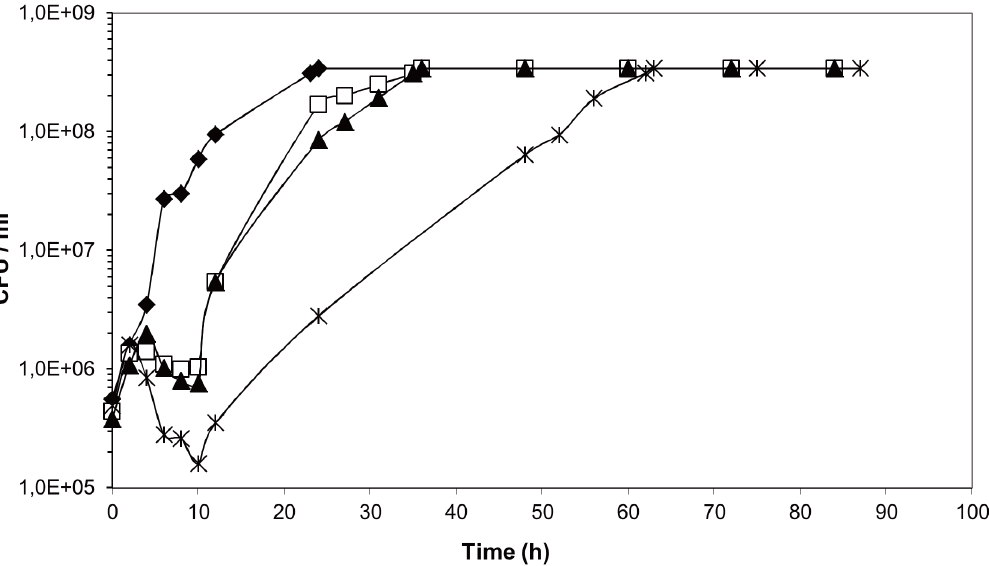
Figure 1. Effects of tannic acid on the growth of L.plantarum WCFS1 . Cells were grown in RPM media supplemented with increasing tannic acid concentrations. Control, X ; 0.1 mM tannic acid, % ; 0.25 mM tannic acid, m ; 0.5 mM tannic acid, X. CFU, colony-forming units. Representative curves are shown. Values at each time point are the average of at least 2 replica plates. Standard deviations (not shown) were less than 10%.